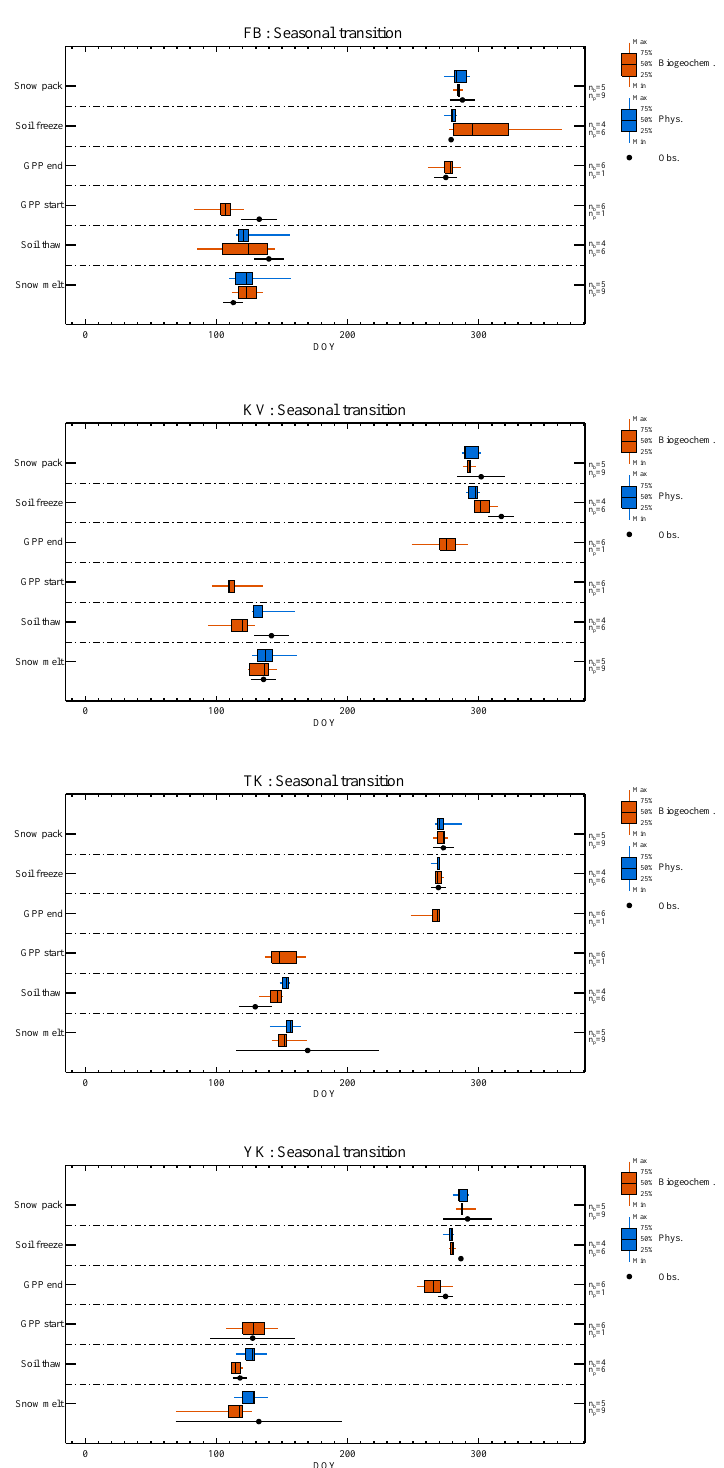
Figure 9. Example of seasonal transitions in ground temperature, snow, and vegetation among